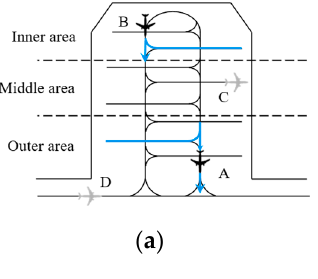
Figure 4. Partition-Shared Operation Procedure. Blue arrows indicate the aircraft operation path. ( a ) shows a scenario where there is a simultaneous pushing back of departure aircraft A and B in the outer and inner sectors (aircraft C and D are waiting to pushback or enter the U-shaped area); ( b ) shows a scenario where there are simultaneous departure aircraft B and A pushing back from the outer and middle areas respectively (aircraft C and D are waiting to pushback or enter the U- shaped area); ( c ) shows a scenario where there are simultaneous departure aircraft B and A from the inner and middle areas respectively (aircraft C and D are waiting to pushback or enter the U- shaped area).